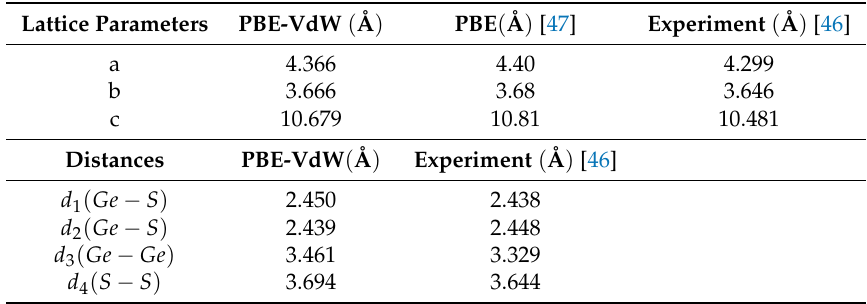
Table 1. Lattice parameters and distances calculated at density function theory (DFT) level taking into account VdW interaction compared with experimental results [46] and previous theoretical results [47].